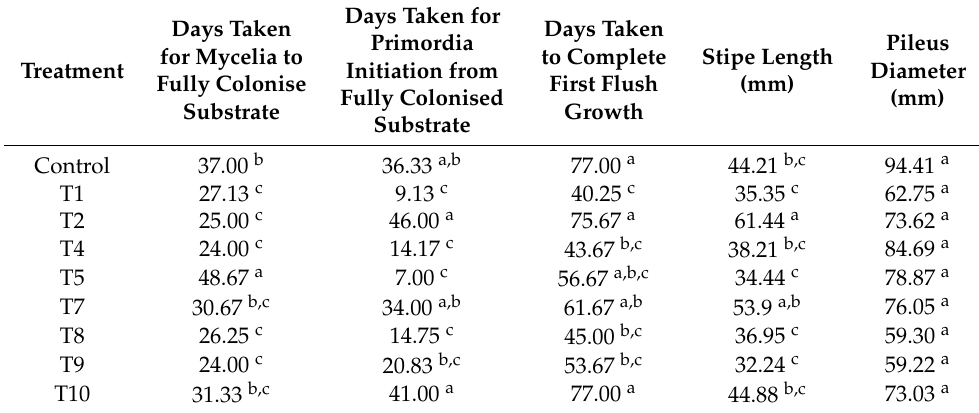
Table 5. Growth of Pleurotus ostreatus.